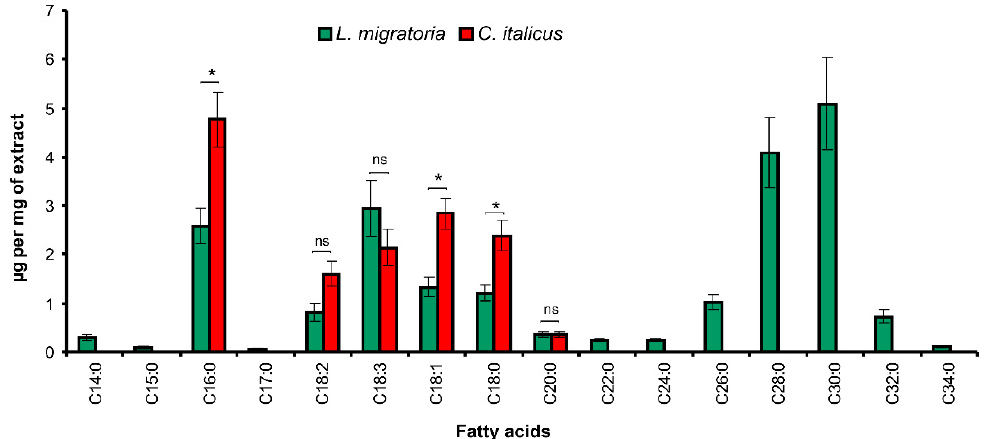
Figure 3. The profile of fatty acids in epicuticular extracts of L. migratoria and C. italicus nymphs. * Significant differences between the species ( t -test, p < 0.05); ns: nonsignificant